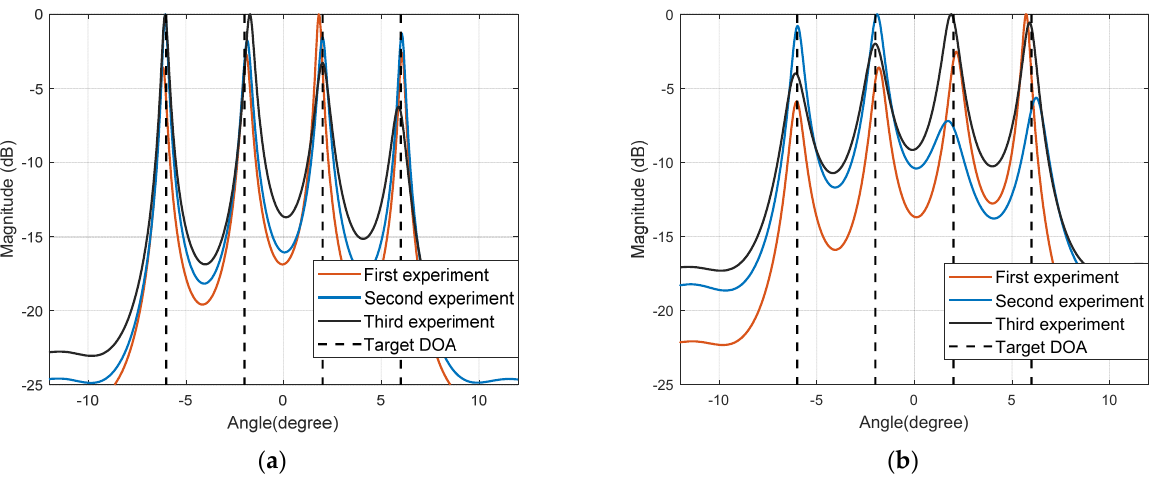
Figure 2. Algorithm space spectrum under the background of GMM noise: ( a ) c 2 = 0.1; ( b ) c 2 = 0.3.